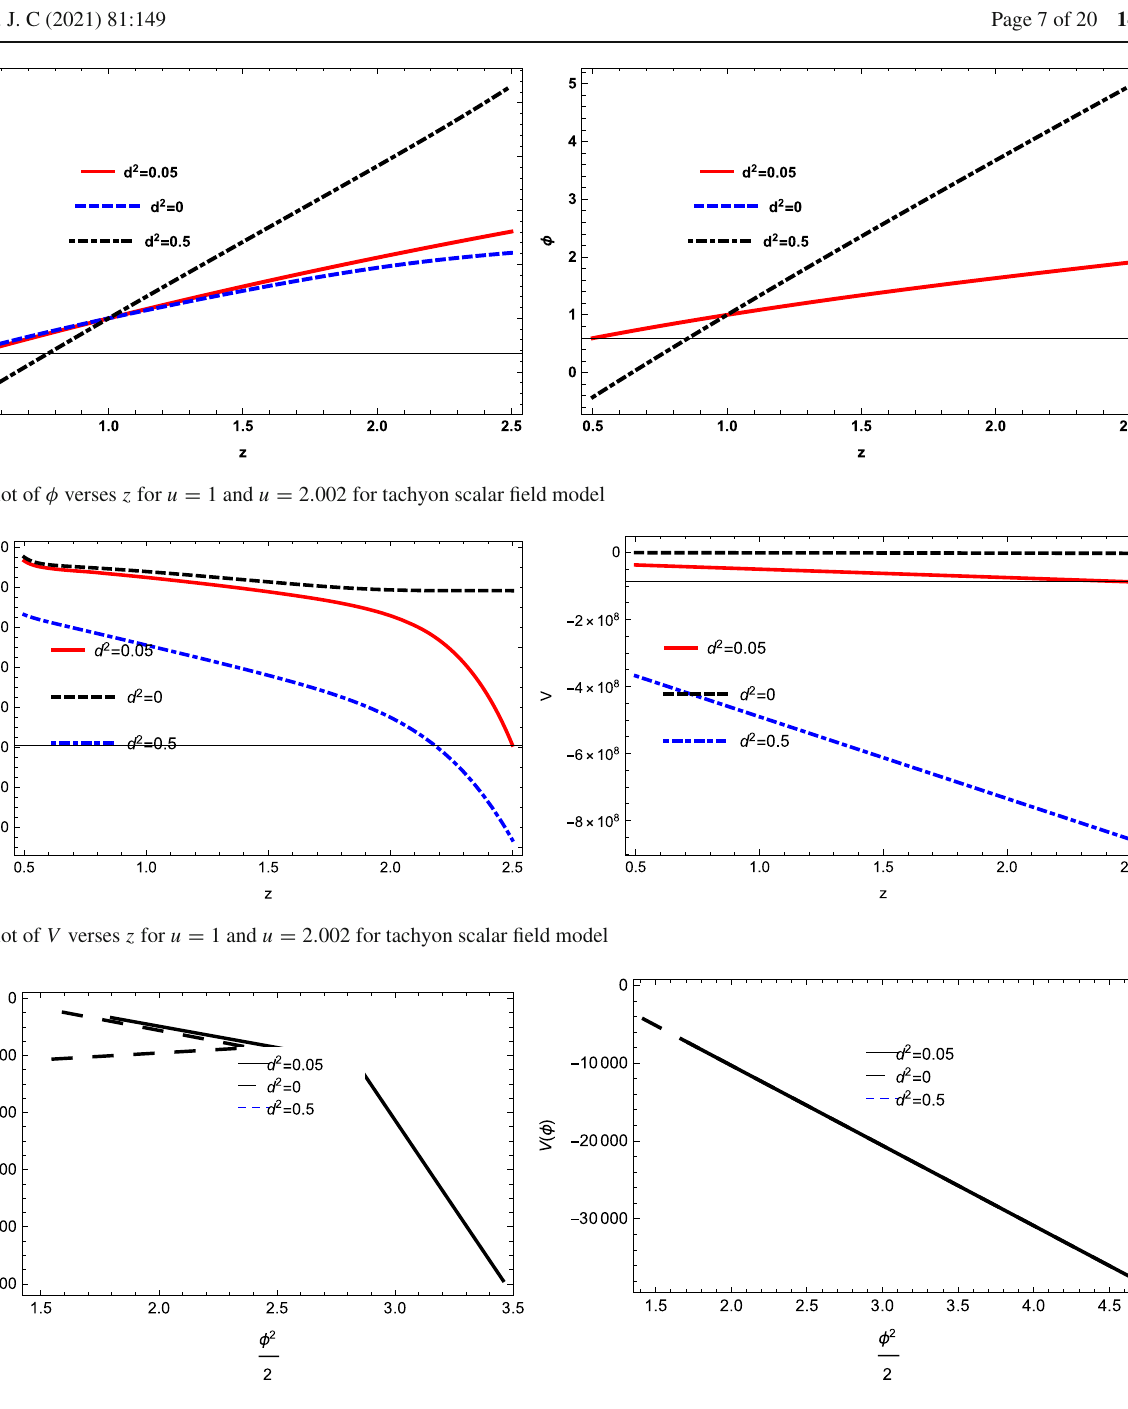
Fig. 10 Plot of φ verses V for u = 1 and u = 2 . 002 for tachyon scalar field